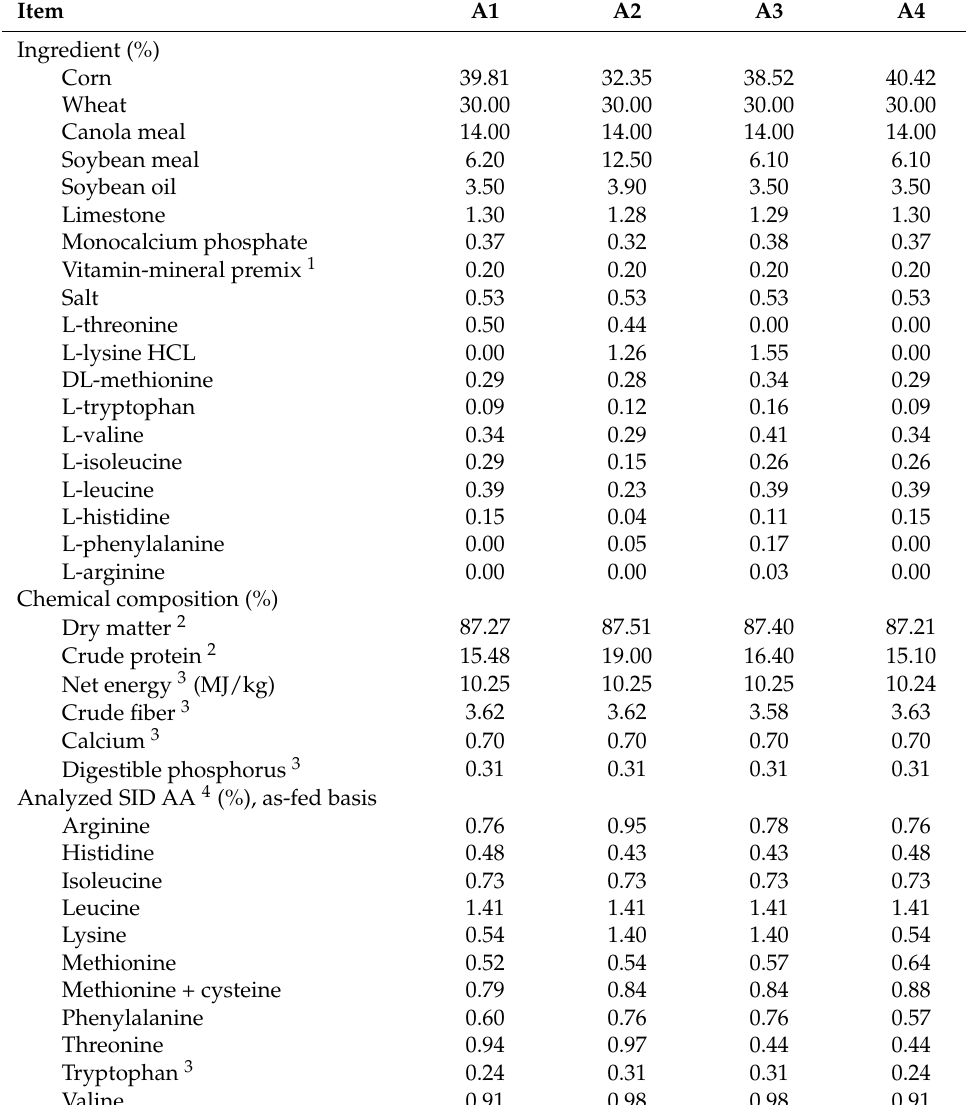
Table 1. Feed ingredients and nutrient composition of the experimental feeds A1, A2, A3, and